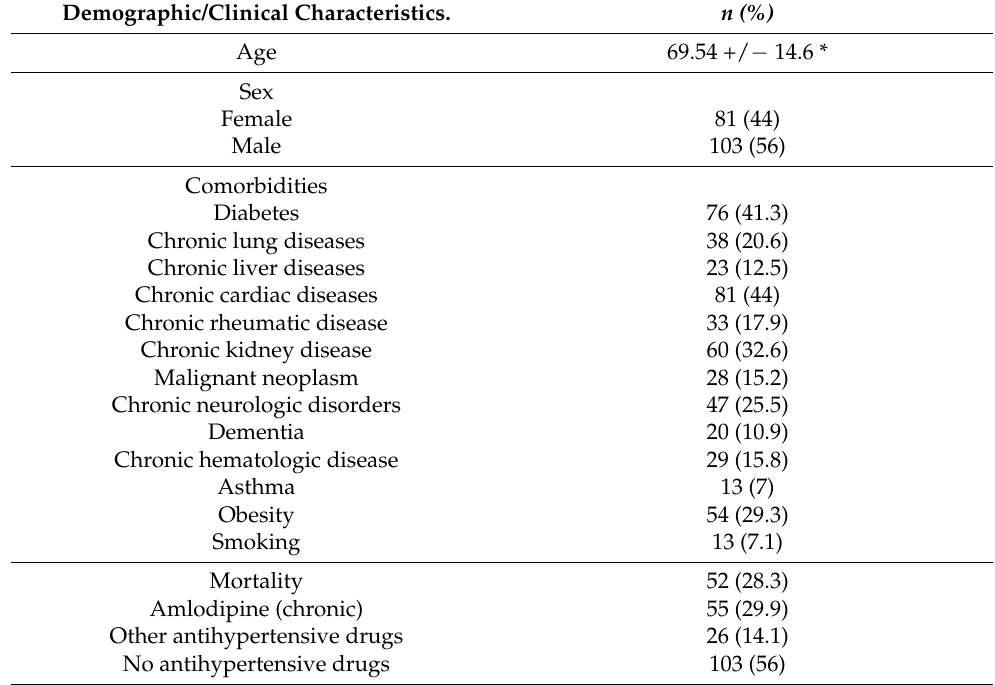
Table 1. Demographic and clinical characteristics of inpatients with COVID-19 with hypertension ( n = 184).